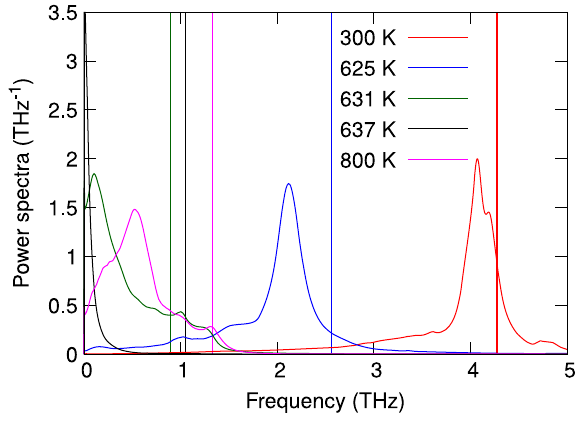
Fig. 3 Spectral function for the zone centre A 1 mode in GeTe at different temperatures. Vertical lines represent the values of the TDEP A 1 ( Γ ) frequencies at different temperatures. A drastic deviation from the Lorentzian shape is evident for the entire temperature range and most prominent in the vicinity of the phase transition (634 K).